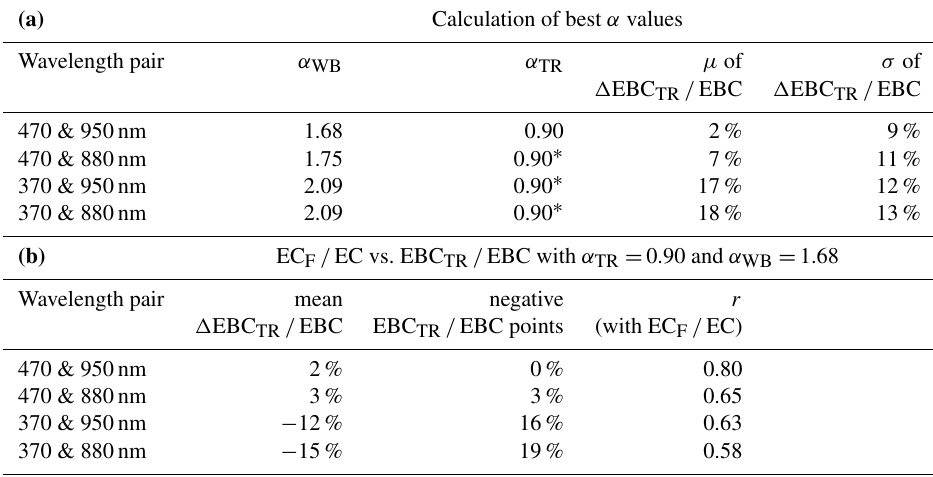
Table 3. Evaluation of the Aethalometer model using different wavelength pairs. (a) Calculation of the α values by fitting Eq. (13) (MAC TR / MAC WB = 1) against EC F / EC. (b) comparison between EC F / EC and EBC TR / EBC calculated with α WB = 1.68 and α WB = 0.90, representing the best α pair for all data, for different wavelength pairs. µ and σ denote the center and the standard devia- tion of the Gaussian fit of the residuals of EBC TR / EBC compared to EC F / EC,